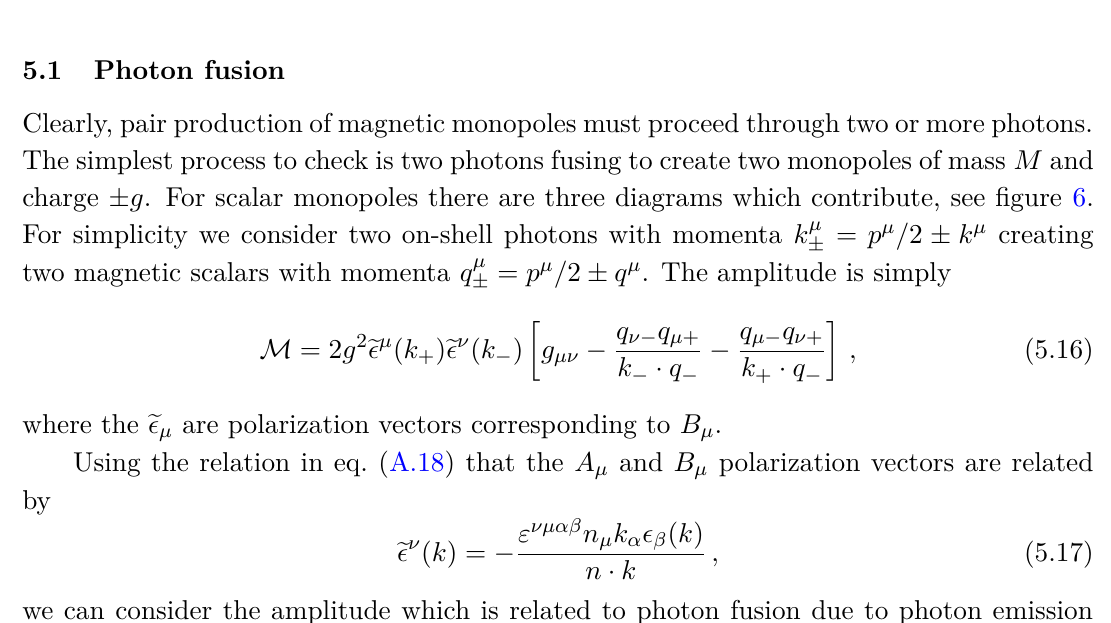
Figure 6 . Photon fusion of scalar